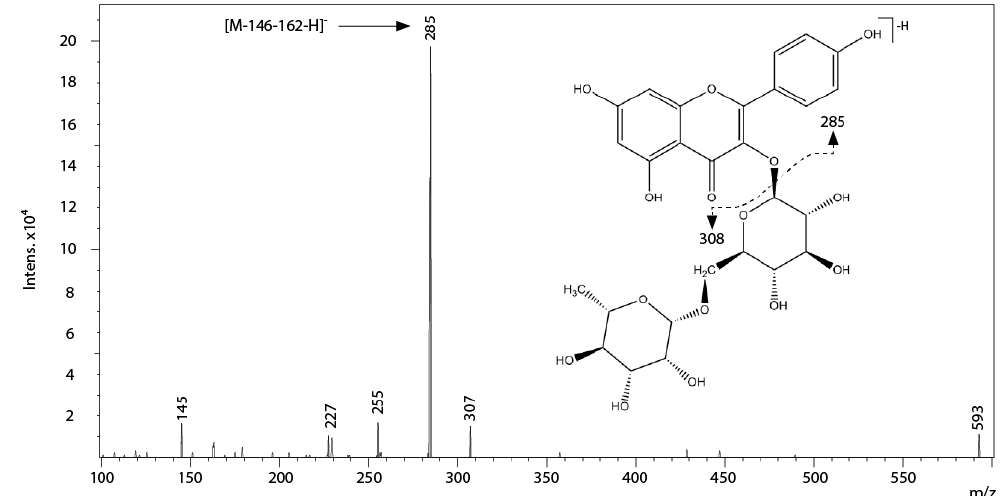
Figure 4. Structure, fragmentation and MS/MS spectrum of peak 18.